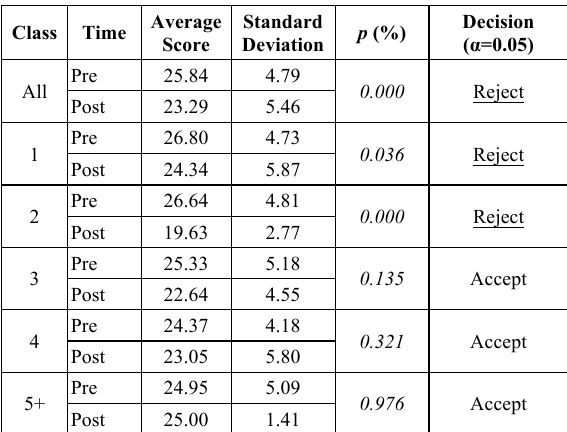
Table 7. Results of Perceived Competence versus Class